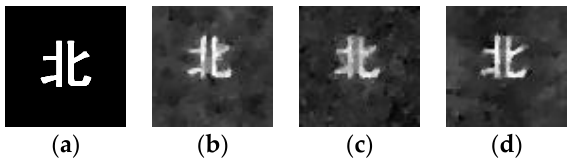
Figure 6. Results obtained by the single-pixel camera: ( a ) target image; ( b ) recovered images using LCS-MM, PSNR = 13.13 dB, SSIM = 0.11; ( c ) recovered images using LCS-CMM, PSNR = 11.59 dB, SSIM = 0.08; ( d ) recovered images using LCS-PRC-MM, PSNR = 14.72 dB, SSIM = 0.13.